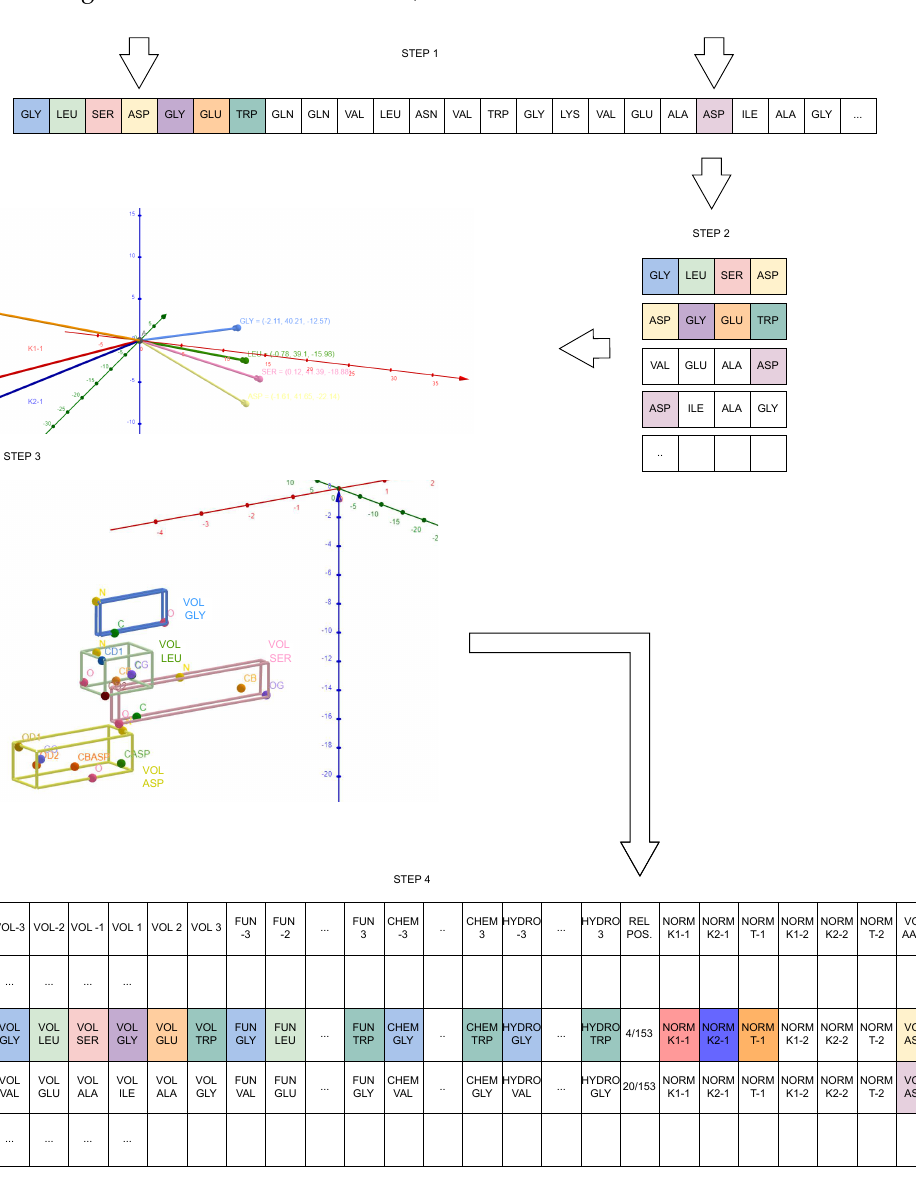
Figure 6. The schema of the dataset construction. The colors of the cells highlight the connection between the amino acids and the relative features with the same